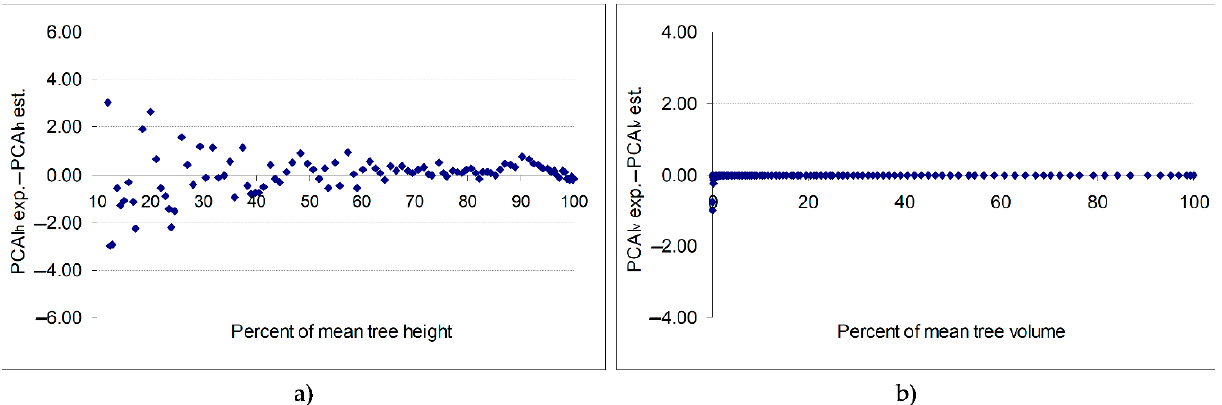
Figure 2. Errors between the experimental values and those predicted by models: ( a ) between the experimental values (PCAI h ) and those calculated based on percentages predicted by Equation (5); ( b ) between the experimental values (PCAI v ) and those calculated using Equation (7). The differences calculated were expressed in relation to the height ( a ) and volume ( b ) of the mean tree. Table 4. Proportion of the PCAI fh in the PCAI v equation (Equation (7)). Tree Height, h = 31.6